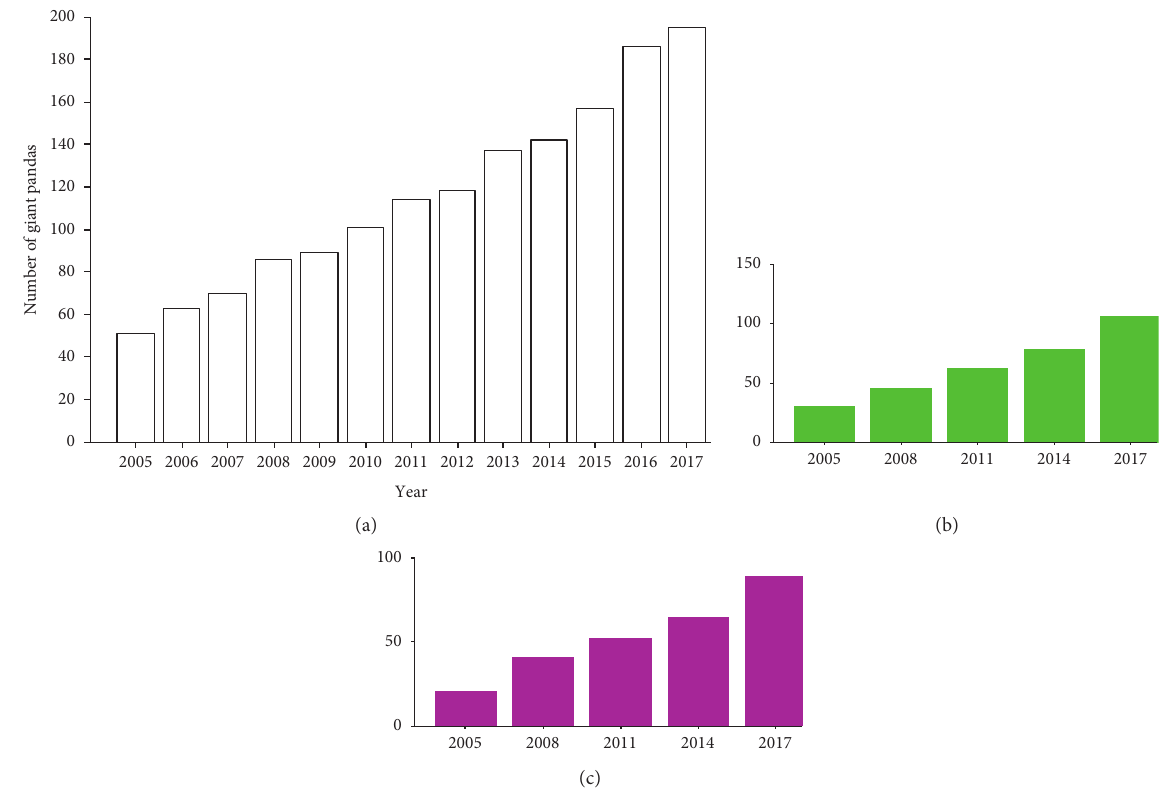
Figure 4: Population size of endangered giant pandas published in the last 13 years, where all the used data are shown through three histograms. (a) Ecological data: the total number of real giant pandas in each year. (b) Female data: the number of female individuals in a selected year. (c) Male data: the number of male individuals in a selected year. (That is, N A � N B + N C ; N presents the number of giant pandas.). Such datasets are called statistical datasets which are generally used as the input for